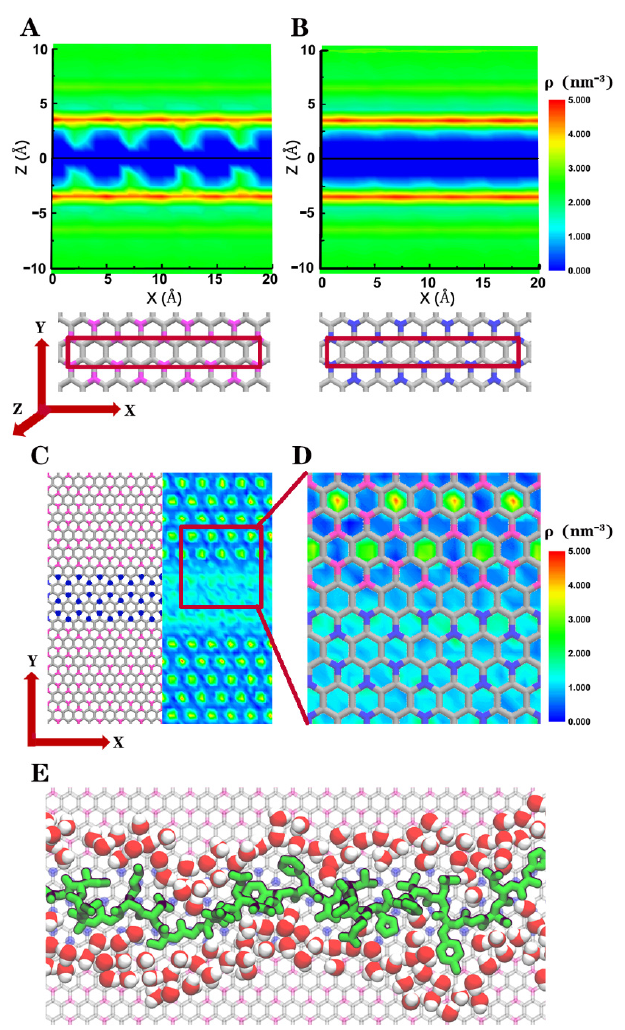
Figure 5. The density maps of water along the normal directions of the ( A ) BC 3 and ( B ) C 3 N planes, where the 2D materials are located at Z = 0. As shown in the structure below, the calculation was performed along the zigzag direction, while only water molecules inside the red square were calculated. ( C ) Two-dimensional water density map on the BC 3 /C 3 N/BC 3 sur- face; water molecules within ± 0.25 nm in the Z direction were counted. ( D ) Magnified map of water density at the bound- ary of BC 3 and C 3 N. ( E ) Straightened A β peptide on BC 3 /C 3 N/BC 3 with interfacial water surrounded; only water molecules within 0.5 nm of both the heterostructure and protein are shown.